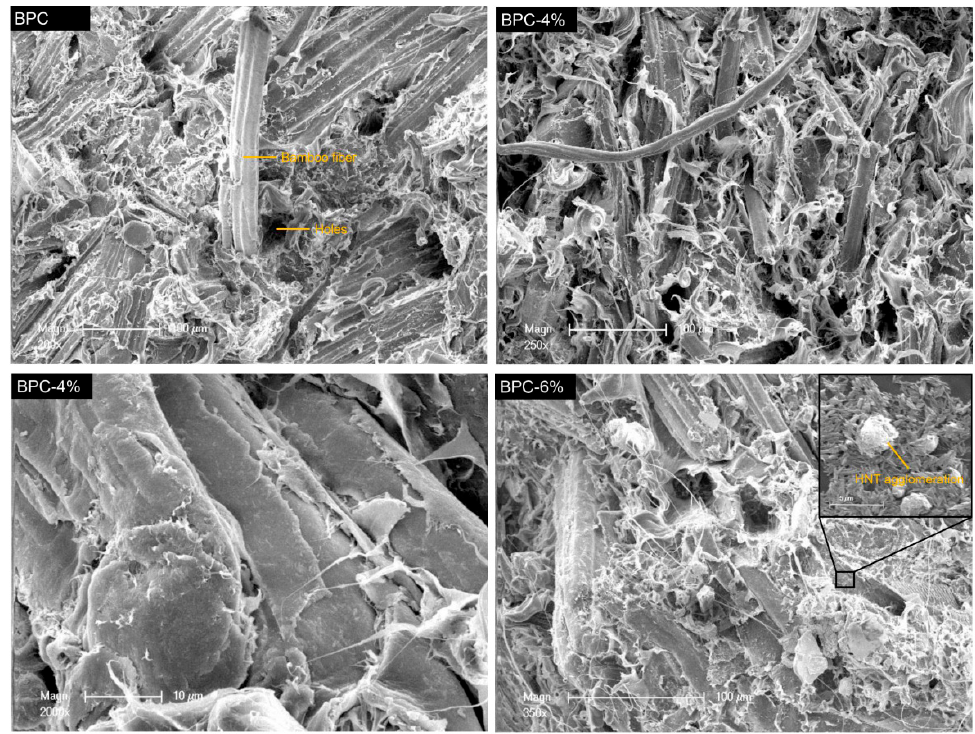
Figure 2. Scanning electron microscopy (SEM) images of impact fracture surfaces of the BPCs.